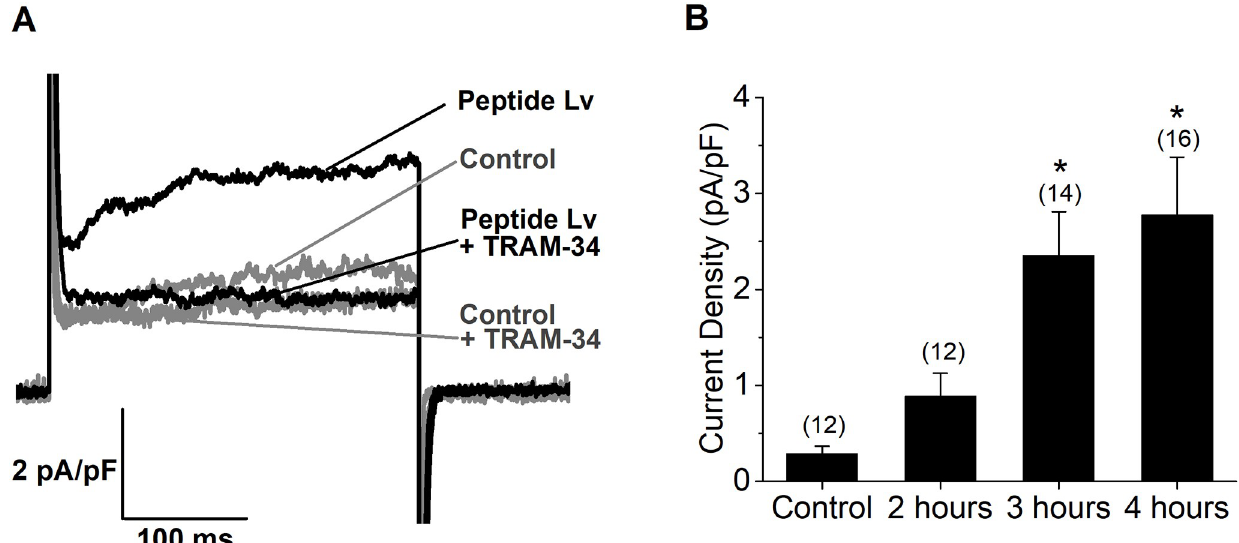
Fig 4. Peptide Lv augments the K Ca 3.1 current densities in HUVECs. Whole-cell voltage-clamp recordings were performed on cultured HUVECs treated with PBS (vehicle control) or peptide Lv (500 ng/ml) for 2, 3, or 4 hours. The outward current was elicited with a step command from a holding potential at -60 mV to 40 mV for 300 ms. From the same cell, the first current was recorded in normal external solution, and then a second current was recorded in the presence of TRAM-34 (10 μ M) to isolate the K Ca 3.1 current. (A) Four representative traces recorded from two cells are shown. The two gray traces are recordings from the control cell (pretreated with PBS) in the absence (upper) or presence (lower) of TRAM-34. The two black traces are recordings from the cell pretreated with peptide Lv for 3 hours in the absence (upper) or presence (lower) of TRAM-34. (B) The current density (pA/pF) was obtained by dividing the K Ca 3.1 current amplitude (measured at 200 ms; the tau point) by the whole cell capacitance. The K Ca 3.1 current density was significantly larger in ECs treated with peptide Lv for 3 (2.36 ± 0.46 pA/pF) or 4 hours (2.77 ± 0.60 pA/pF) but not for 2 hours (0.89 ± 0.24 pA/pF), compared to the control treated with PBS (0.29 ± 0.08 pA/pF). One-way ANOVA followed with Tukey post hoc tests were used for statistical analyses; n = 12–16 for each group; � p <